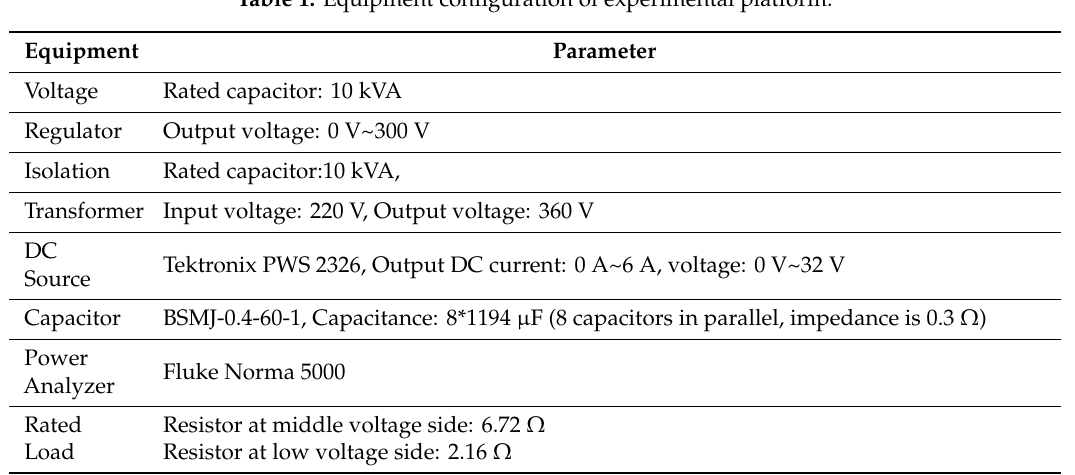
Table 1. Equipment configuration of experimental platform.